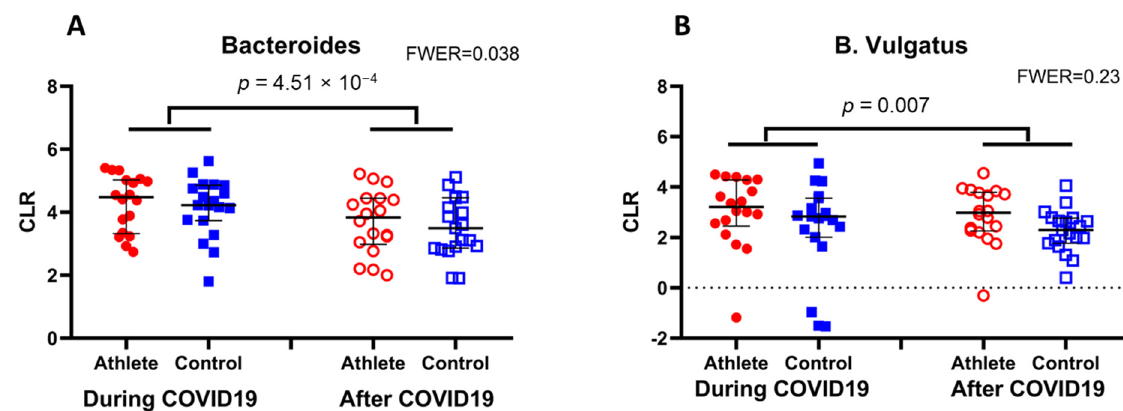
Figure 2. The Bacteroidetes levels were higher during COVID-19 infection than after recovery. The only significant difference was observed at the phylum ( A panel) and species (panel B ) level: the Bacteroidetes had higher abundance at phylum and B. Vulgatus at species level during COVID-19 infection than two–three weeks after a negative PCR test ( p < 0.05). n = 38. The confidence at Bacteroidetes case was 99.19%. CLR: centered log-ratio, n = 38. At the species level, B. vulgatus was elevated during infection when compared to samples gained after recovery from disease (Figure 2). Principal component analysis of gut microbiota composition of subjects with PCR confirmed COVID-19 during and